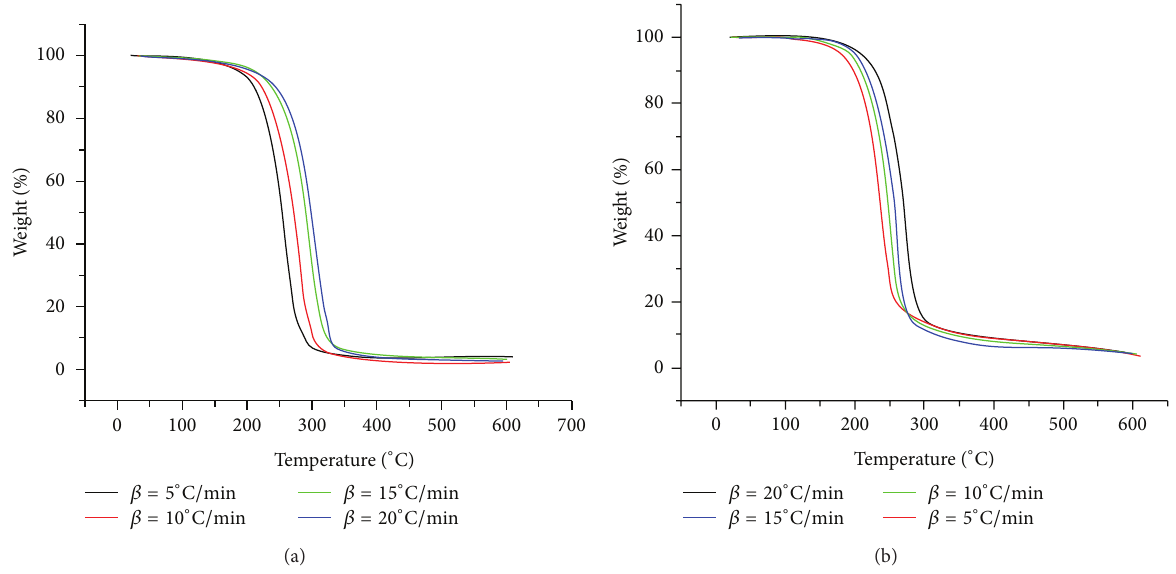
Figure 3: (a) The TG thermograms of compound 1 in argon atmosphere at different heating rates (5, 10, 15, and 20 ∘ Cmin −1 ). (b) The TG thermograms of compound 2 in argon atmosphere at different heating rates (5, 10, 15, and 20 ∘ Cmin −1